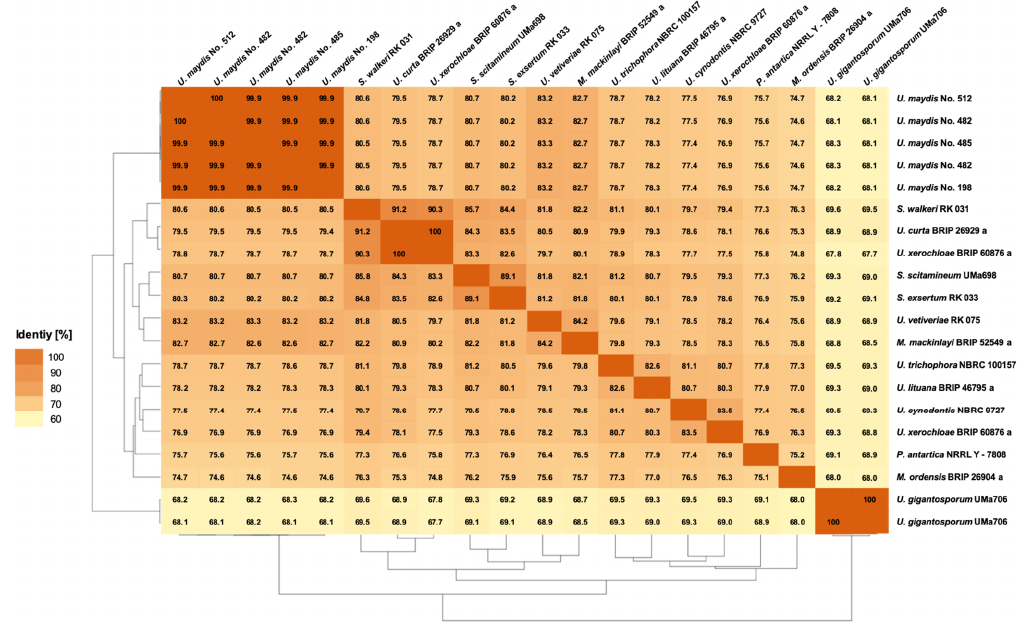
Figure 4. Pairwise Average Amino Acid Identity (AAI) analysis between genome-sequenced Ustilaginaceae. The AAI between the query genome and the reference genome was calculated as the mean identity of all BLASTN matches [42]. Two isolates were sequenced in the case of U. maydis No. 482 and U. gigantosporum Uma706.